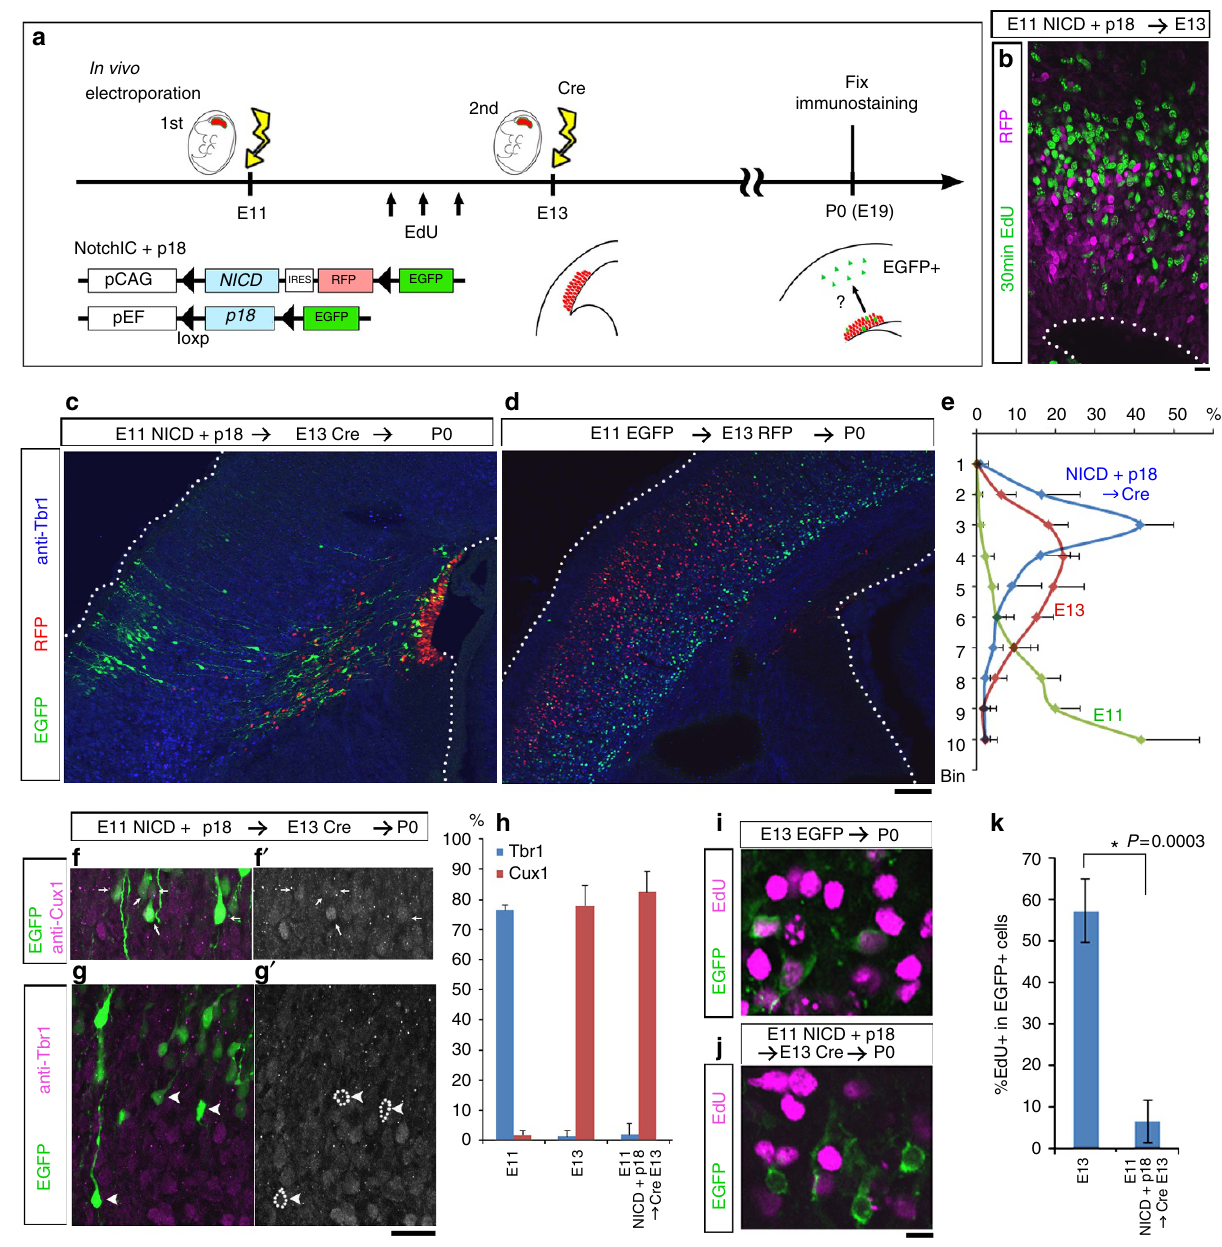
Figure 6 | Laminar fate of progenitor cells is not altered by transient cell-cycle arrest. ( a ) Experimental design of double in vivo electroporation study. ( c ) RFP þ cells did not label with EdU administered 30min before sacrifice at E13. Bar, 10 m m. ( c , d ) Immunostaining with antibody to Tbr1 (blue) of sections from E11 NICD þ p18/E13 Cre double-electroporated P0 brain ( c ) or control E11 EGFP-3NLS/ E13 RFP-3NLS double-electroporated P0 brain ( d ). Scale bar, 100 m m. ( e ) Distribution of the electroporated cells in the CP (cortical plate). CP was separated into 10 bins, and Bin1 represents the most exterior portion of the CP. Data show means ± s.d. from N ¼ 6 embryos for each experimental condition. ( f , g ) Cux1 ( f , f 0 ) or Tbr1 ( g , g 0 ) immunoreactivity in E11 NICD/p18 and E13 Cre double-electroporated P0 brain. Arrows ( f , f 0 ) indicate EGFP þ /Cux1 þ cells, and arrowheads ( g , g 0 ) indicate EGFP þ /Tbr1 (cid:2) cells in the CP. ( h ) Frequency of Cux1 þ or Tbr1 þ cells in electroporated cells in the CP. Data show means ± s.d. from N ¼ 4, 5, 4 (Cux1 data) and 4, 4, 6 (Tbr1 data) embryos for E11, E13, NICD/p18/Cre, respectively. ( i – k ) EdU was administrated three times at 4-hr intervals at E12, and labelling index was examined at P0 CP. Many EGFP þ CP cells that had been electroporated with pCAG::EGFP-3NLS at E13 incorporated EdU ( i ), whereas E11 NICD/p18 and E13 Cre double- electroporated CP cells exhibited no significant incorporation ( j ). Data show means ± s.d. * P ¼ 0.0003, N ¼ 7 and 8 embryos, Mann–Whitney U test. See also Supplementary Fig.